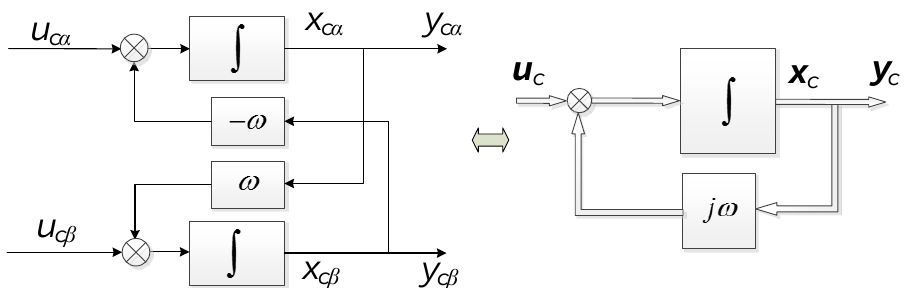
Figure 2. State space structure of the complex variable resonant controller (CVRC).